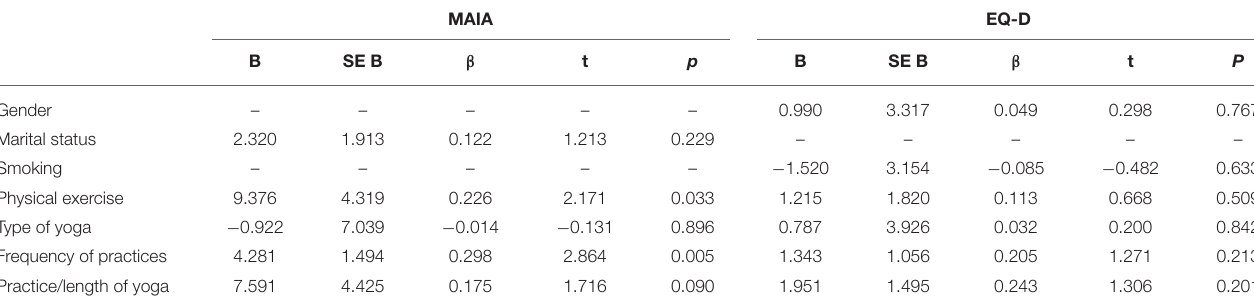
TABLE 8 | Hierarchical regression analysis with practice of yoga and perseverance in it as the predictor variable in total MAIA and EQ-D scores of the Spanish participants after controlling sociodemographic characteristics, life habits, and aspects of yoga practice.